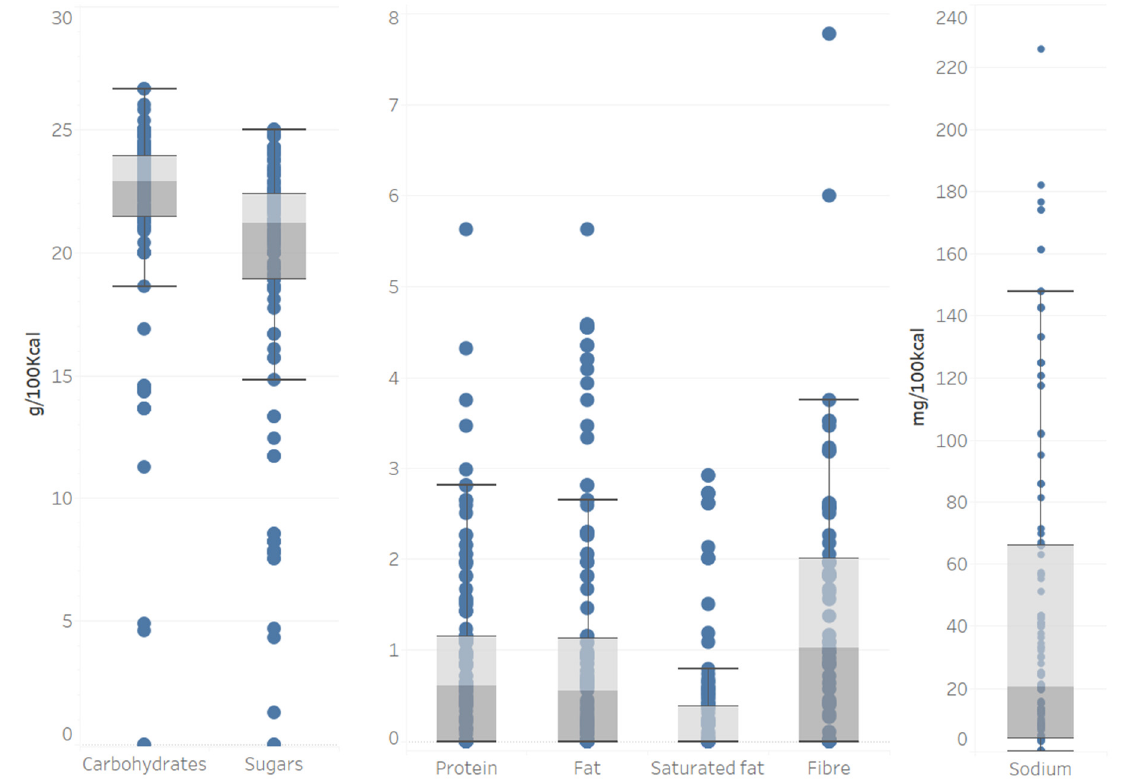
Figure A4. Nutrient content (g/100 kcal product, except for sodium mg/100 kcal product) of ‘Baby juices and drinks’.